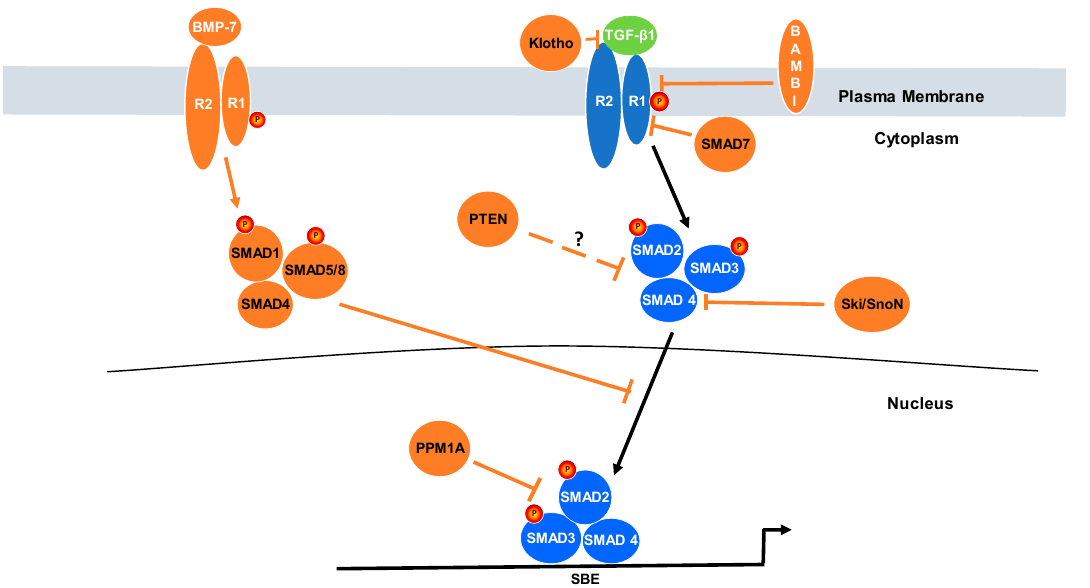
Figure 2. A Complex Network of Negative Regulators Fine-tunes TGF- β 1-Driven Phenotypic Modifications in Cancer. TGF- β 1-SMAD2/3 signal transduction (highlighted in blue) is subject to modification by a number of repressors (highlighted in orange) that function at the levels of the receptor or SMAD2/3 activation, nuclear translocation and promoter binding as depicted above. Deregulation of such negative controls could profoundly influence TGF- β 1-induced genetic programs in tumorigenesis.